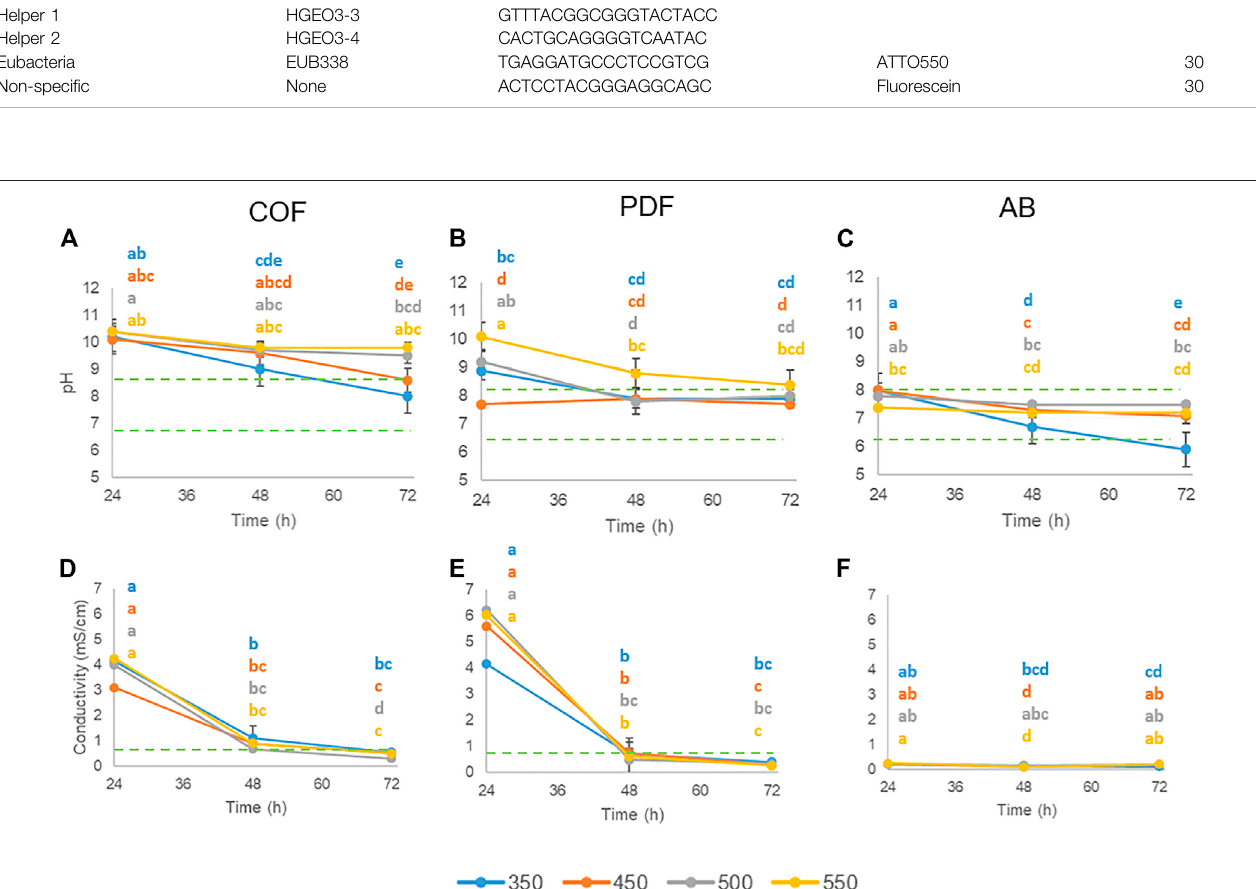
FIGURE 1 | pH-H 2 O measurements (A – C) and conductivity (D – F) of biochar:water suspensions (1:20) after 24, 48, and 72 h, for the 3 biochars produced at 4 temperatures(350,450,500,and550 ° C).Theinteraction-termbetweentemperatureandtimewassigni fi cantat p < 0.05.Samelettersindicatenosigni fi cantdifferences between the terms, p < 0.05, n = 3 (two-way ANOVA, TukeyHSD).